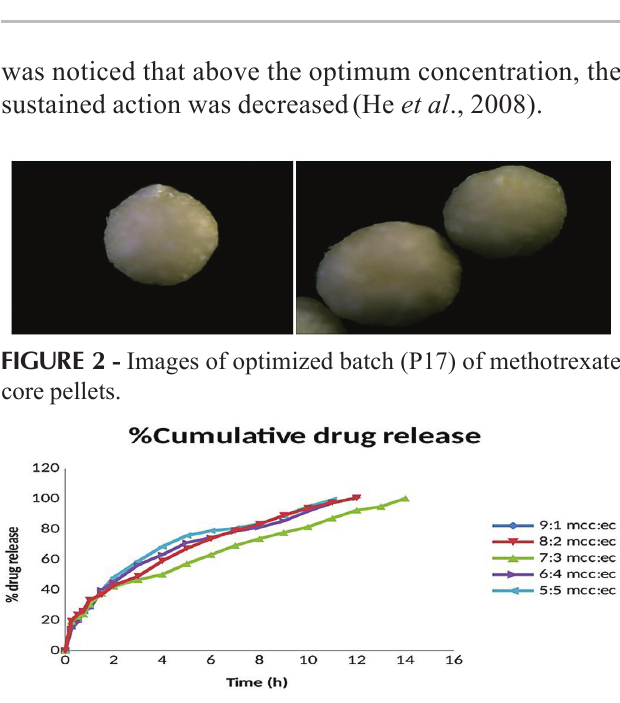
FIGURE 3 - % Cumulative drug release of methotrexate core pellets.